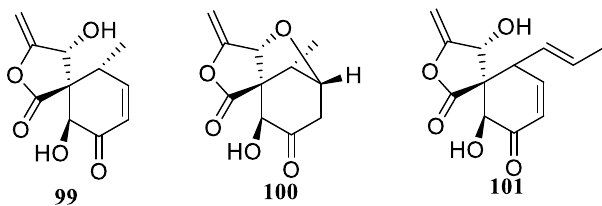
Figure 42. Lambertollols A and B.